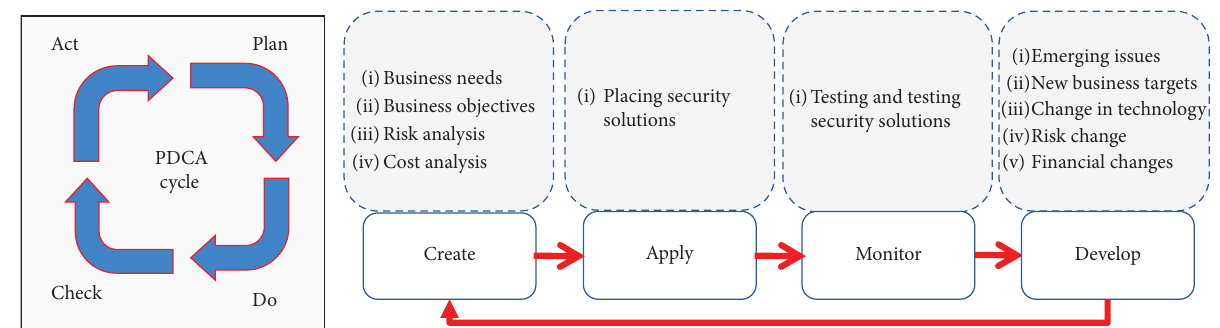
Figure 6: PDCA cycle model and corporate cyber security lifecycle [43, 44].